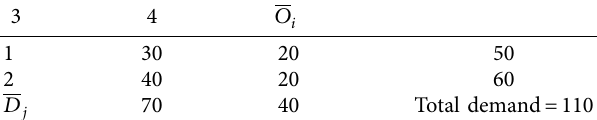
Table 2: Fixed travel demand in the network.